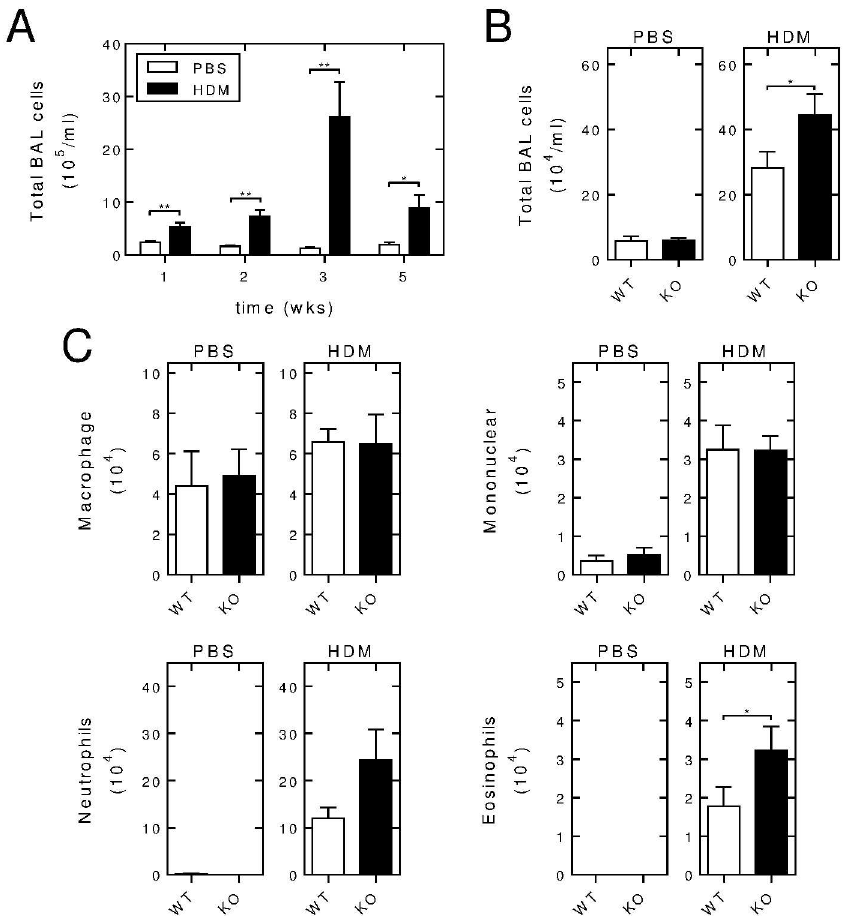
Fig 5. Effect of RGS2 deficiency on inflammatory cells in the BAL fluid. A, Wild type C57/Bl6mice were subjectedto i . n . instillationof PBS or HDM (25 μ g) 3 times/week for 1, 2, 3 or 5 weeks. BAL fluid was collected and total cell counting was performed. Data ( N = 4–7 for PBS- and 6–11 for HDM-exposed) are plotted as means ± SE. B, Wild type (WT) and Rgs2 -/- (KO) mice were subjectedto i . n . treatment with PBS (left panel)or HDM (25 μ g) (right panel)3 times/week for 3 weeks. BAL fluid was collectedfor total cell counting.Data ( N = 14 for PBS-exposed wild type and Rgs2 -/- , N = 23 for HDM-exposed wild type and 18 Rgs2 -/- ) are plotted as mean ± SE. C, Wild type and Rgs2 -/- mice were exposedas in B. Cells in the BAL fluid were pelletedonto glass slides by cyto-centrifugation, stained with Diff-Quik, prior to differentialcell countingof at least 400 cells per slide. Percentagesof macrophages, mononuclear cells, neutrophilsand eosinophils were convertedinto absolutenumbersusing the respectivetotal cell counts. Data ( N = 8 PBS-exposedwild type and Rgs2 -/- , N = 17 HDM-exposed wild type and 12 Rgs2 -/- ) are plotted as means ± SE. Significance was tested between wild type and Rgs2 -/- groupsby unpairedMann Whitney U test. * P < 0.05, ** P <